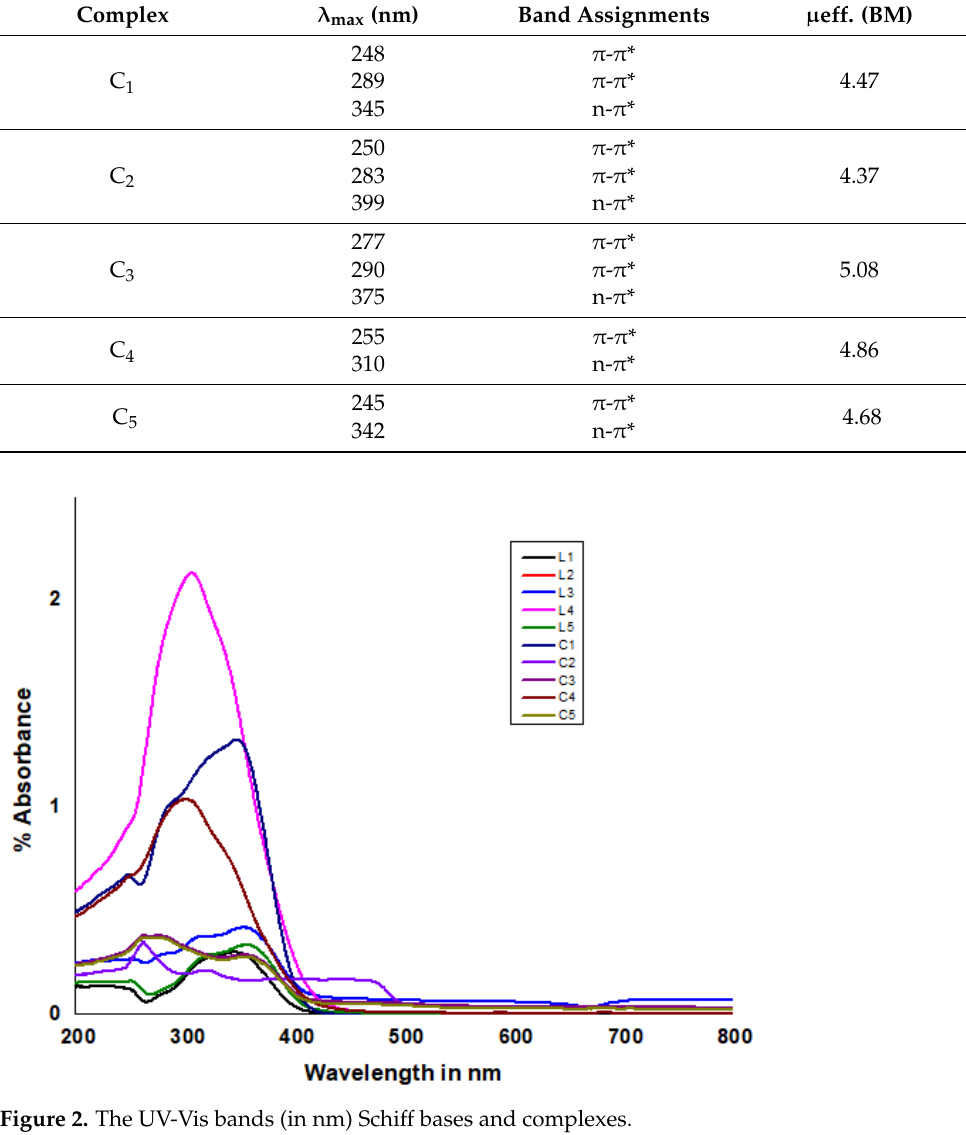
Figure 2. The UV-Vis bands (in nm) Schiff bases and complexes. Table 2. Electronic spectral and magnetic moment values for Co(II)-Schiff base metal complexes.